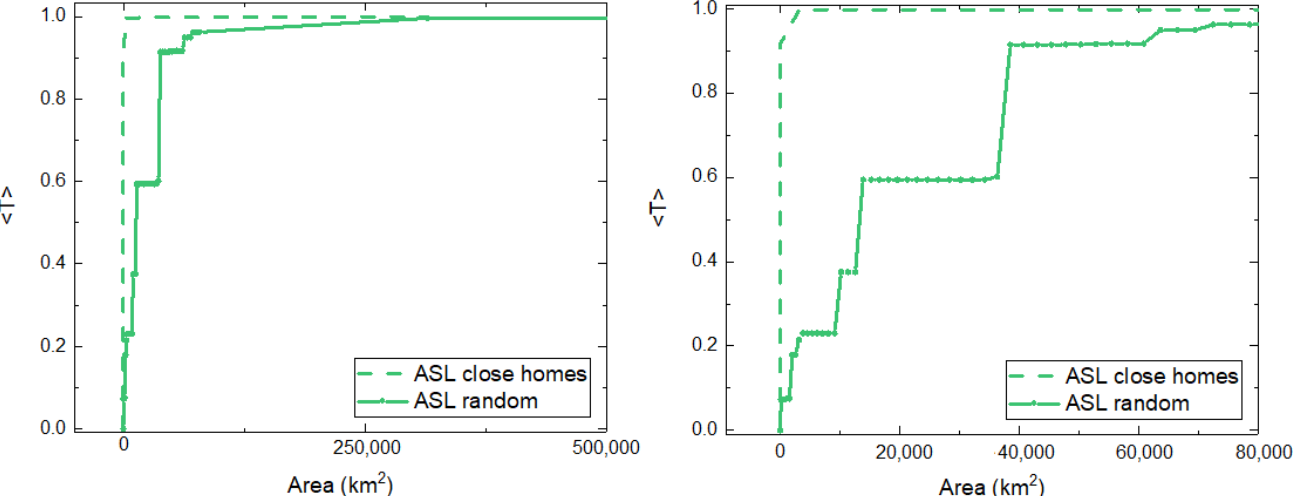
Figure 10. ( Left ) Average number of transmitted packages per unit of time as a function of the covered area for the case of ASL with a random distribution of receiver stations (line) and close to homes (dash). ( Right ) Same values as the left panel for total reception areas smaller or equal than 78,500 km 2 , which corresponds to the case of 10 receiver stations with a reception radius r = 50 km 2